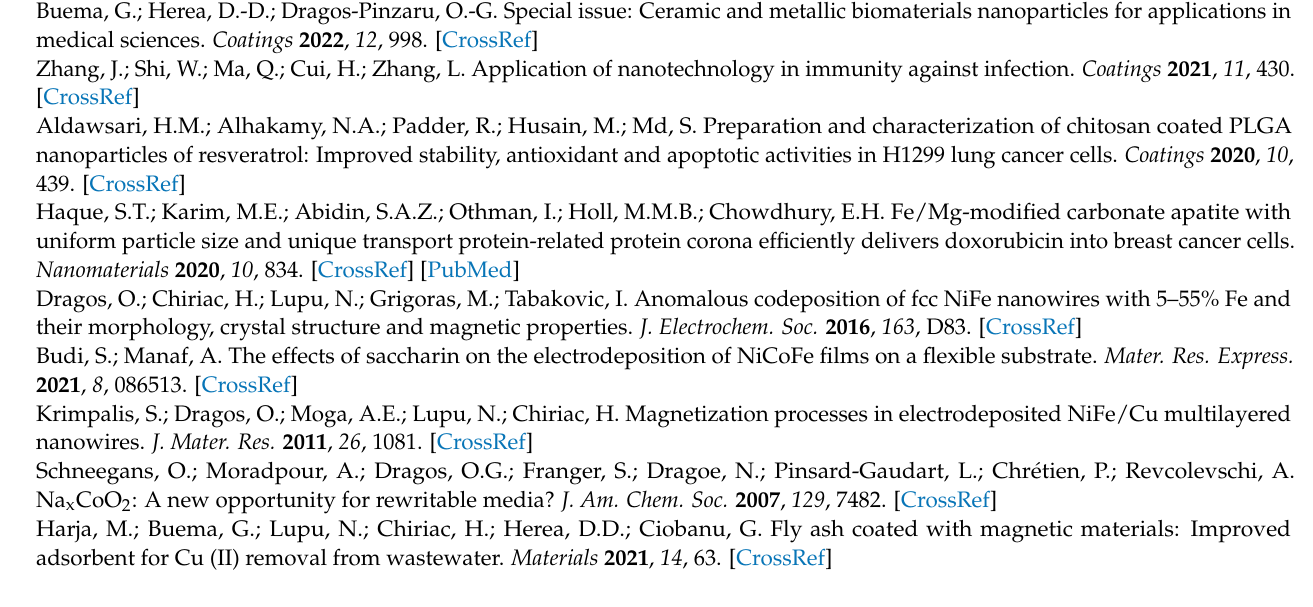
Figure S3: XRD patterns of the CoFe nanowires arrays; Figure S4: SEM picture of the CoFe@Au core–shell